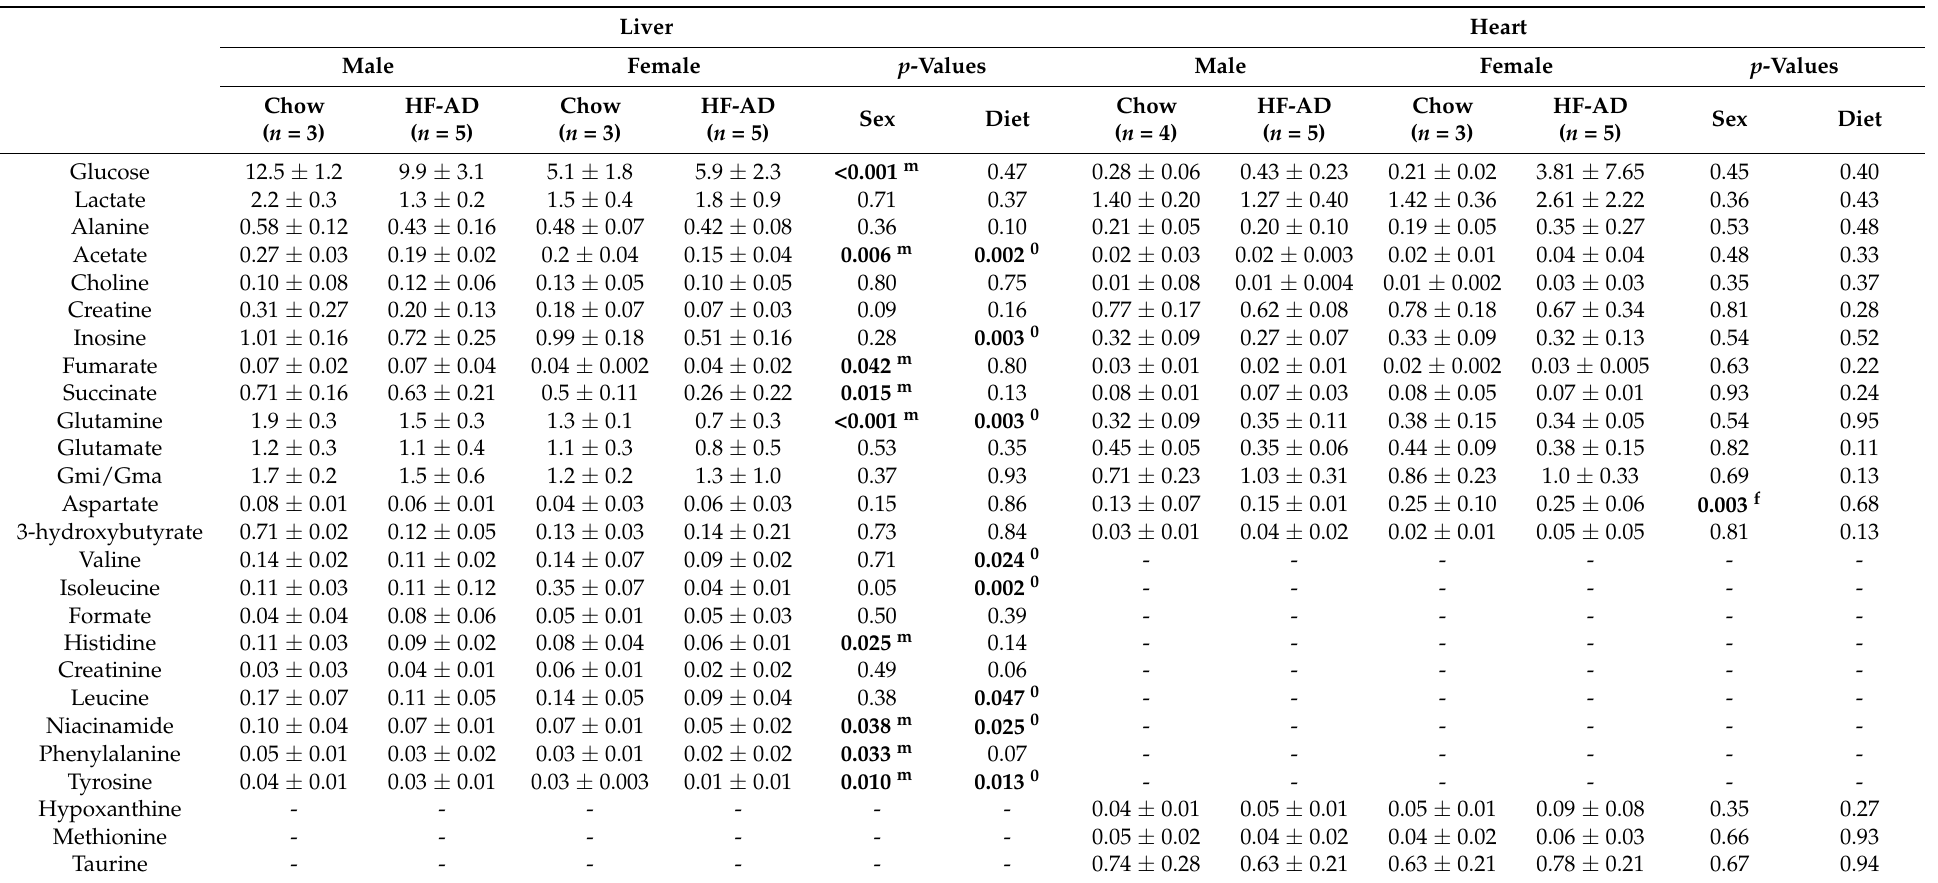
Table 2. Hepatic and cardiac aqueous metabolite concentrations (mM) indicated as mean ± standard deviation for both male and female chow and high-fat ad libitum (HF-AD) groups. Liver Heart Male Female p